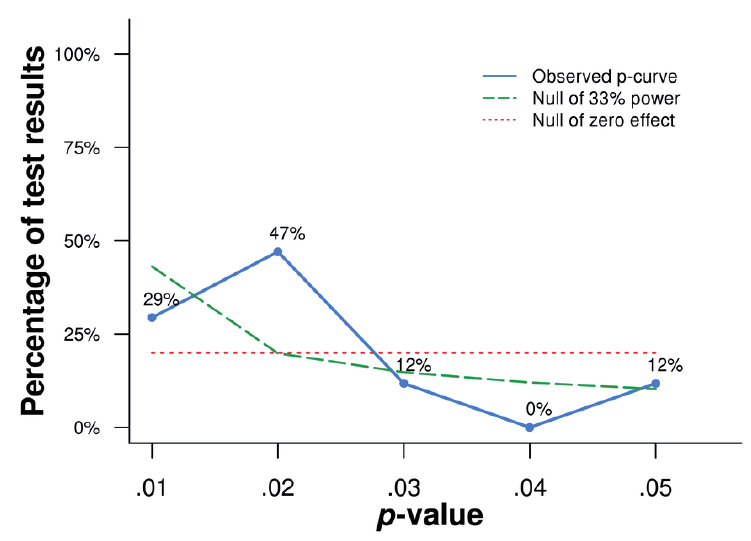
Figure 2. Distribution of the significant p values across experiments in the